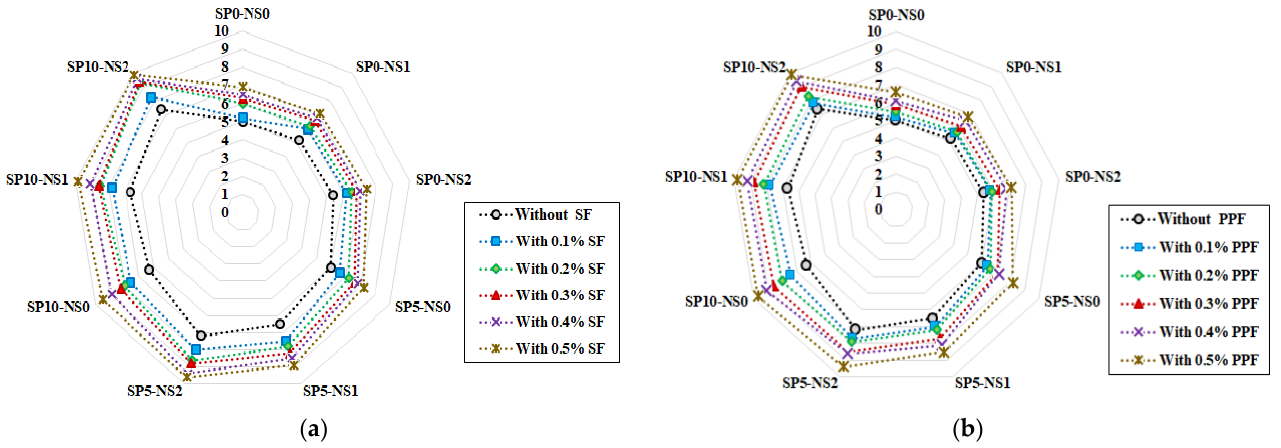
Figure 11. Effect of the fibres on the splitting tensile strength of HSC containing ( a ) NS and ( b ) SP.